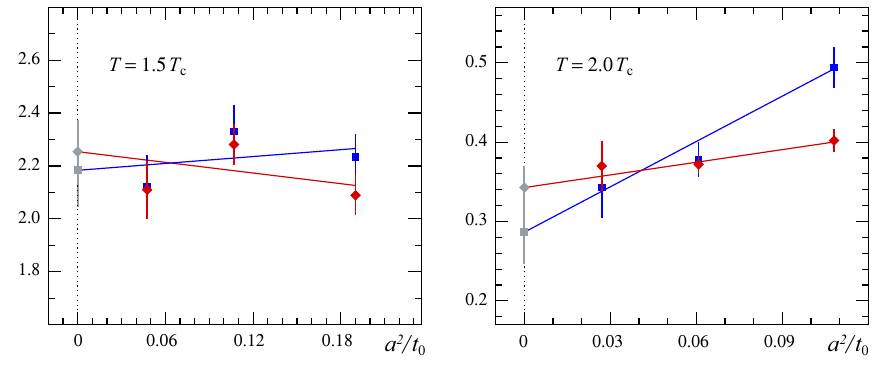
Fig. 4 Extrapolation of the χ × 10 5 listed in values of t 2 t 0 Table 3 to the continuum limit (left: A -lattices, right: B -lattices). The data at flow time 0 . 35 t 0 (squares) and 0 . 97 t 0 (diamonds) are extrapolated linearly in a 2 , the grey points at a = 0 being the extrapolated